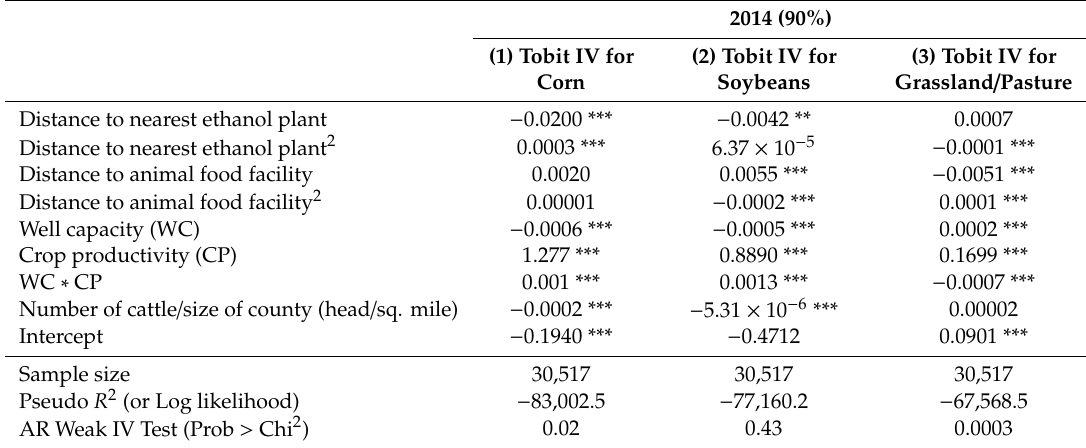
Table 6. Robustness check with Tobit IV for corn, soybeans, and grassland /